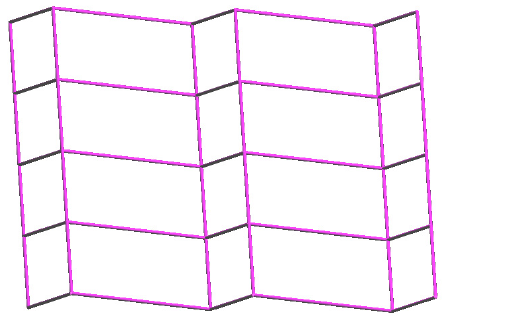
Figure 3. ( a ) Coordination environment of Ni(II) ion in 2 . Symmetry transformations used to generate equivalent atoms: (A) x + 1, y, z + 1; (B) x, y, z − 1. ( b ) A drawing showing the sql topology.